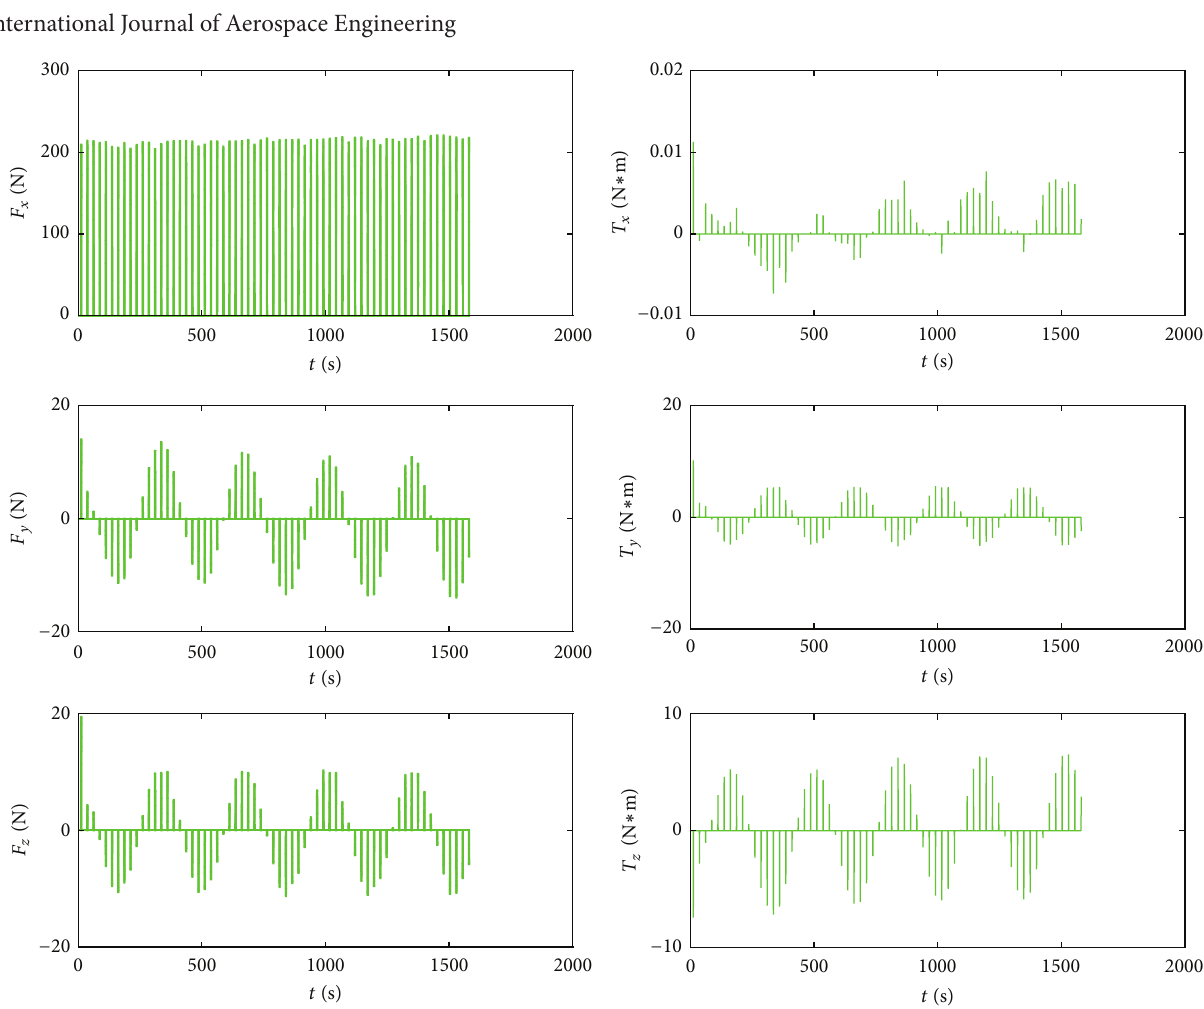
Figure 11: The components of the tension force ( 𝐹 𝑥 , 𝐹 𝑦 , and 𝐹 𝑧 ) and the disturbing torque ( 𝑇 𝑥 , 𝑇 𝑦 , and 𝑇 𝑧 ) in 𝜋 𝐴 caused by the tether.